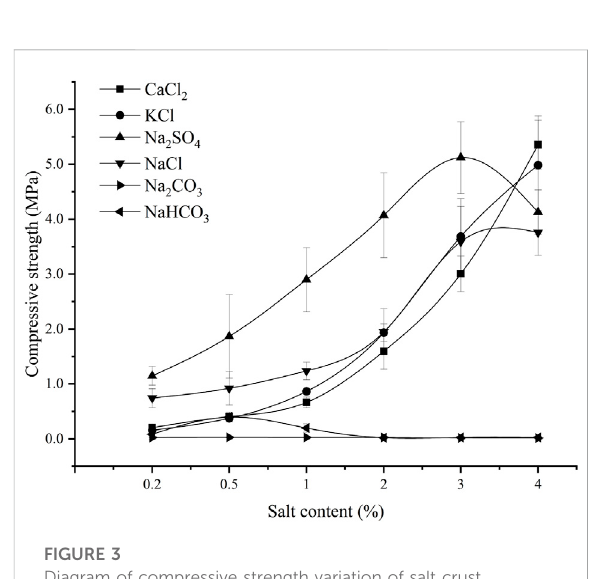
FIGURE 3 Diagram of compressive strength variation of salt